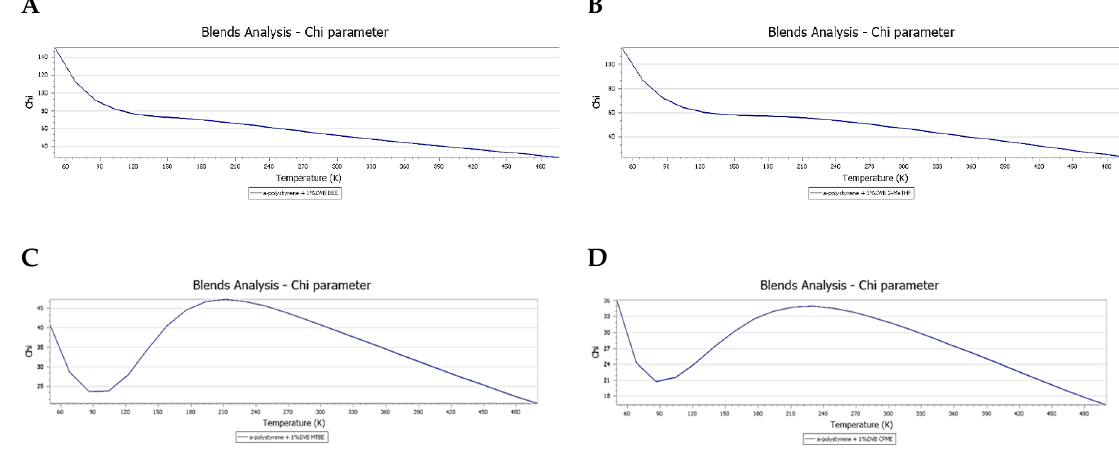
Figure 5. Chart displaying Chi ( χ ) dependence on temperature (50–500 K): ( A ) DEE; ( B ). 2-MeTHF; ( C ) MTBE; and, ( D ) CPME. Chi ( χ ) values at the working temperature in this study (280 K): DEE; 55.5 > 2-MeTHF; 49.3 > MTBE; 42.8 > CPME;